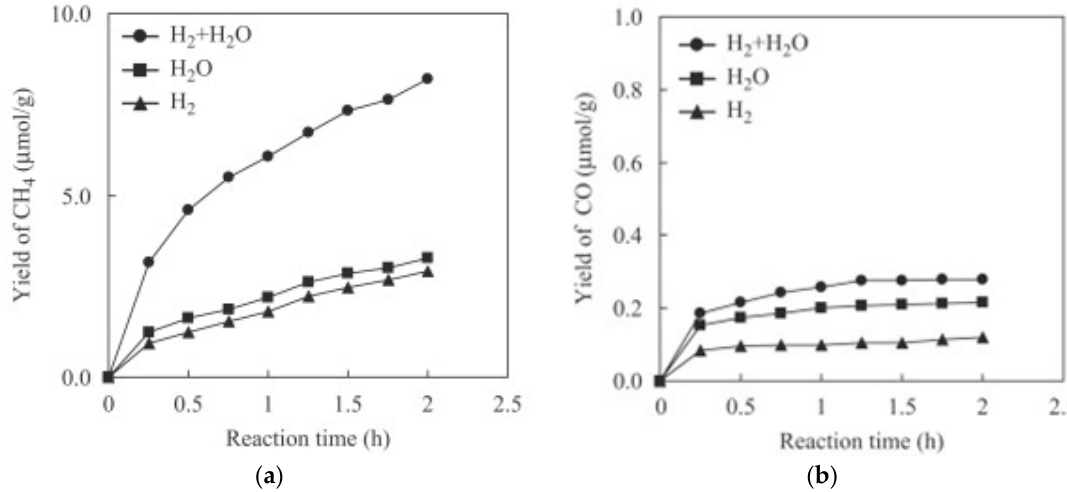
Figure 6. Effect of reductant on the yield of CO 2 photoreduction products, i.e., CH 4 ( a ) and CO ( b ). Reproduced from work in [60]. Copyright 2007 Elsevier B.V.